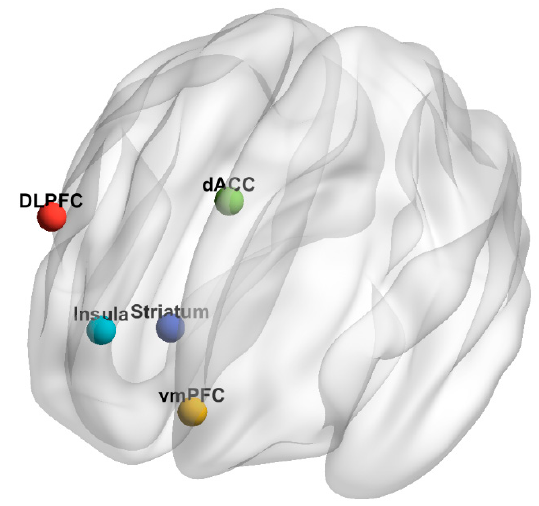
Figure 1. Graphical representation of seed locations. DLPFC, dorsolateral prefrontal cortex (red). vmPFC, ventromedial prefrontal cortex (yellow). dACC, dorsal anterior cingulate cortex (green). Insula (light blue). Striatum (dark blue).